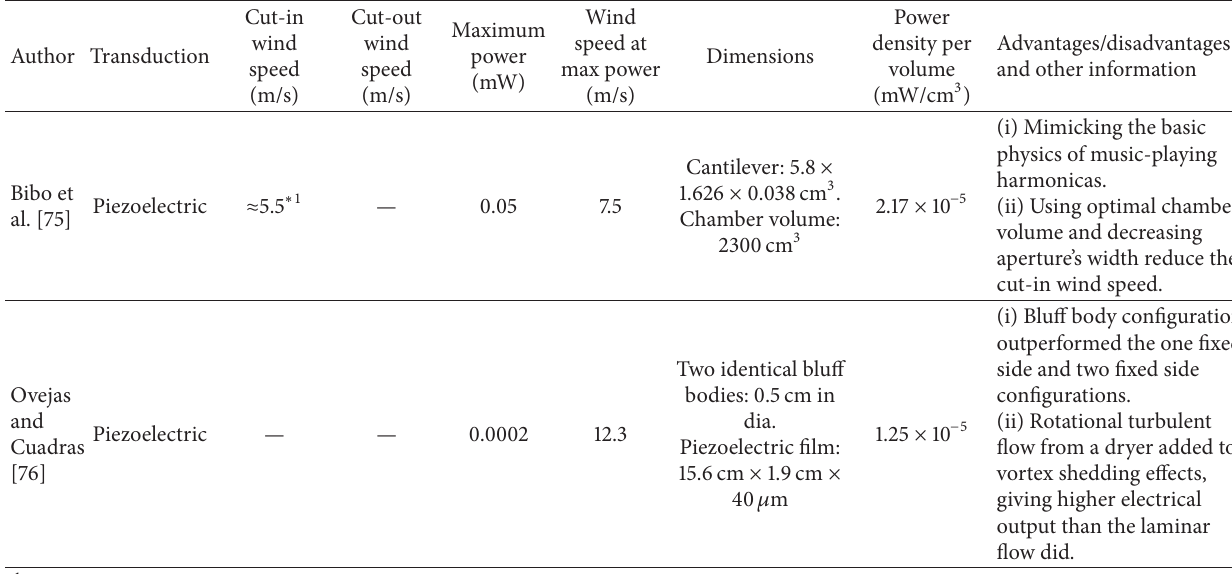
Table 8: Summary of other types of energy harvester devices.